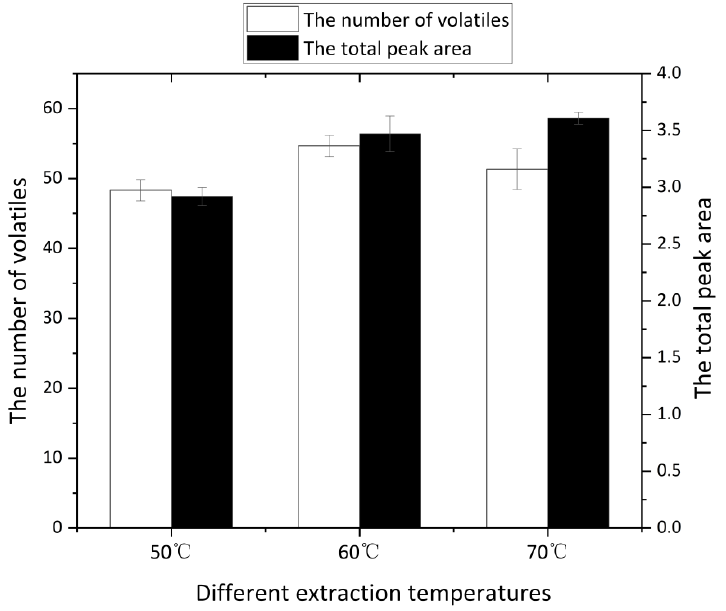
Figure 3. Comparison of extraction results at different extraction temperatures.